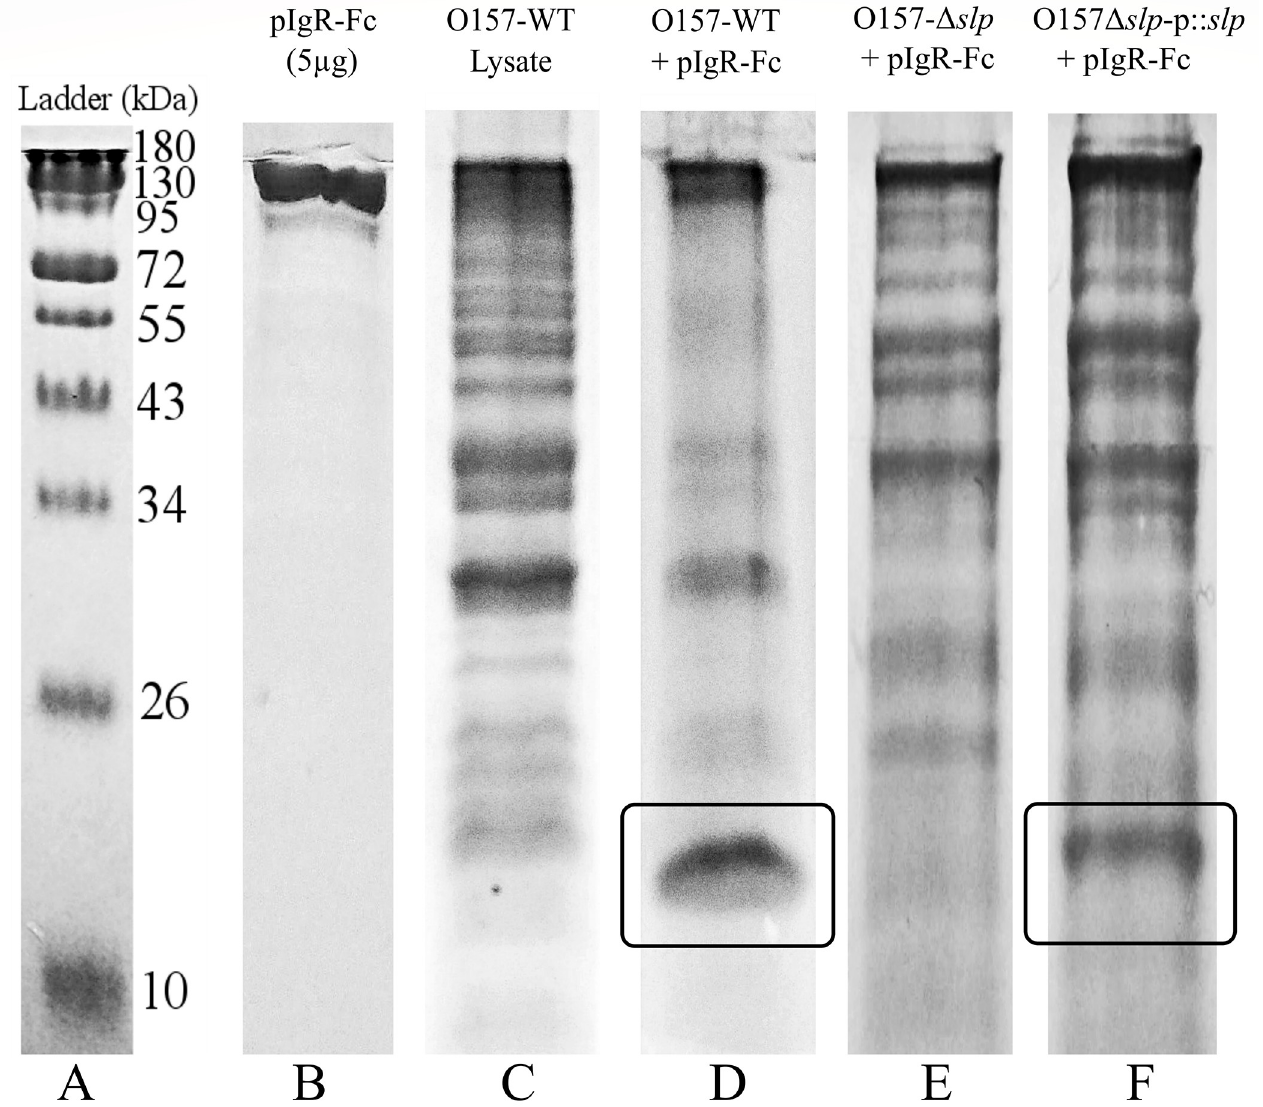
Fig 3. Co-immunoprecipitation of E . coli O157:H7 proteins with human recombinant Fc-tagged pIgR protein. SDS-PAGE showing the apparent sizes of proteins in the conditions used for Co-IP. The protein of ~20 kDa in size, which was co-precipitated with pIgR is enclosed in a box. The bands in the boxed areas were selected for LC MS/MS